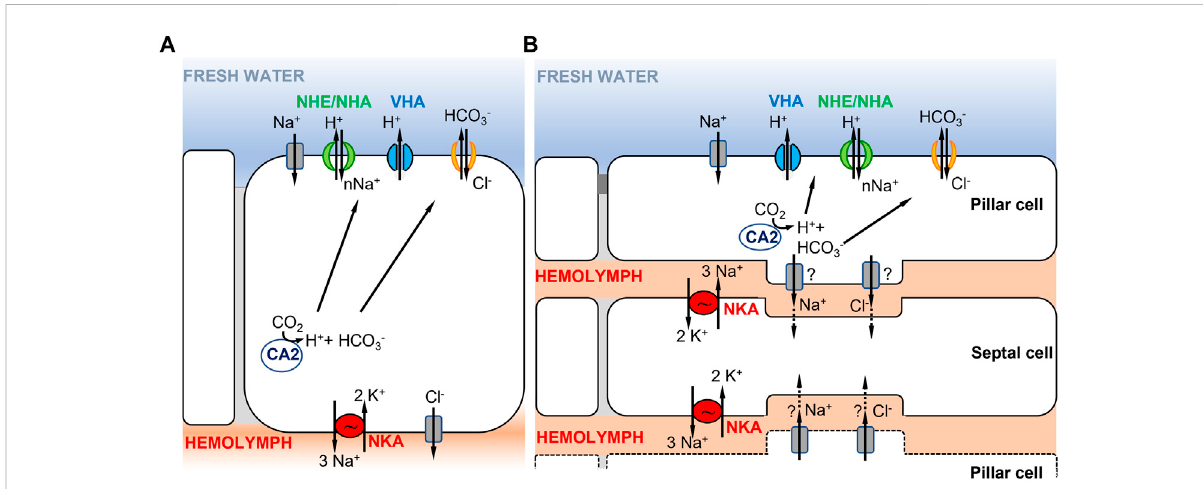
FIGURE 2 Hypothetical ionocyte models of ion uptake for crustaceans in freshwater habitats. (A) A single ionocyte, as found in decapods and particularly inbrachyuran crabs(fromTowleand Weihrauch, 2001;Charmantieretal.,2009).Underlow salinityconditions, theapically localizedVHA transports H + out of thecell,driving Na + entry into thecell through an unknown electrogenic Na + transporter. (B) Cooperatingionocytes, pillar and septal cells, as found in different species of palaemonid shrimps (adapted from McNamara and Faria, 2012; Boudour-Boucheker et al., 2014). On the apical membrane of pillar cells, VHA drives Na + uptake into the cell as in (A) . Na + is then passed to septal cells and then transported to the hemolymph by NKA located on the membrane of septal cells. In both models in (A,B) , the type of apical ion transporter responsible for transporting Na + from